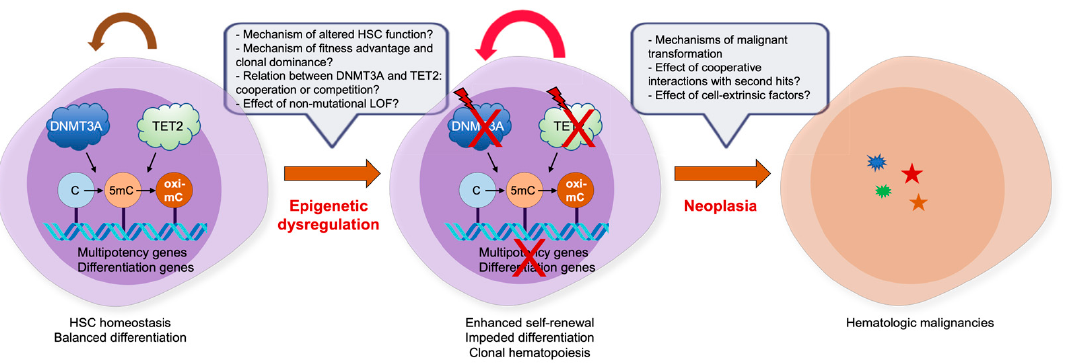
Figure 3. Impact of DNMT and TET mutations in CHIP and hematologic malignancies. Despite the progress we have made in the last decades to decipher the role of epimutations, such as DNMT3A and TET2 LOF mutations, there are still many outstanding issues. For details, refer to the text.